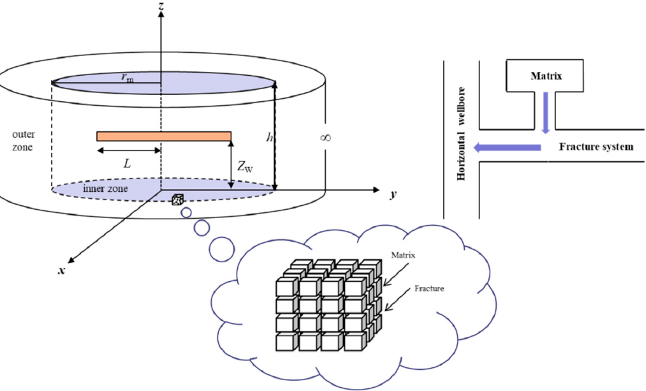
Figure 1. Physical model of the dual–porosity medium.